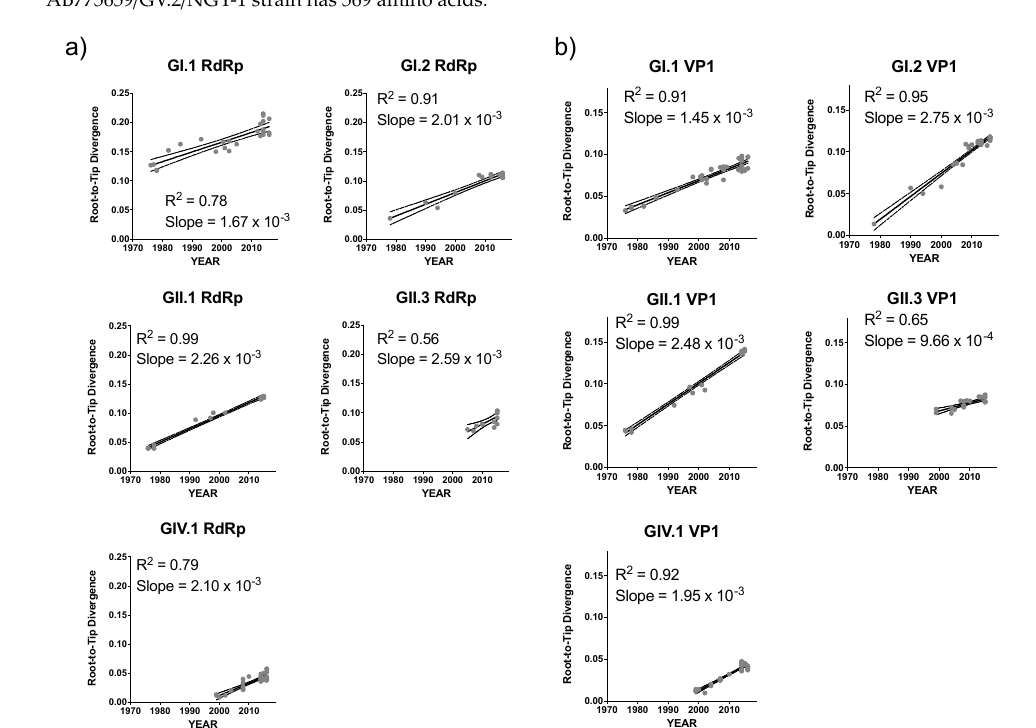
Figure 3. The time-ordered genetic divergence pattern of the RdRp- and VP1-encoding nucleotide sequences of major sapovirus genotypes. Root-to-Tip linear regression analyses were performed to investigate the association between genetic divergence of the ( a ) RdRp- and ( b ) VP1-encoding nucleotide sequences and collection years. The x-axis indicates the collection year and the y-axis shows the root-to-tip divergence on the maximum-likelihood tree. Linear lines indicate the best-fit linear regression of root-to-tip divergence, based on the collection years. Strains are represented by grey dots.